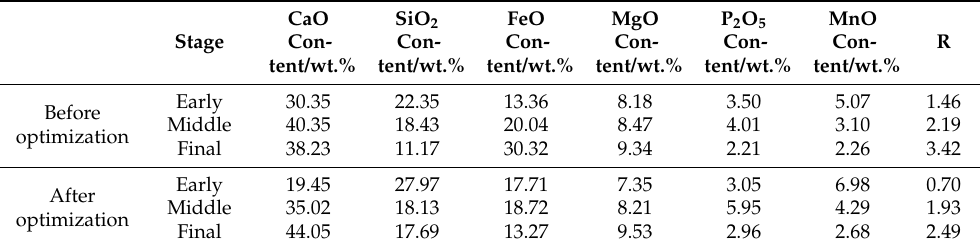
Table 3. A comparison of slag compositions of each stage before and after the optimization of the slag-forming route.